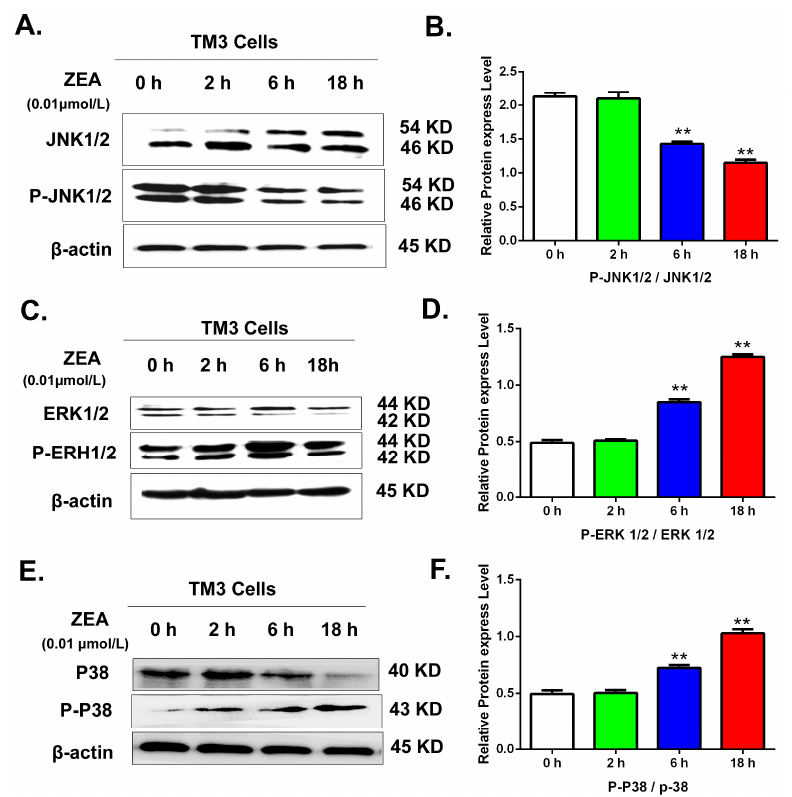
Figure 10. The e ff ects of ZEA on the MAPK family proteins including JNK1 / 2, p-JNK1 / 2, ERK1 / 2, Figure 10. The effects of ZEA on the MAPK family proteins including JNK1/2, p-JNK1/2, ERK1/2, P- P-ERK1 / 2, p38 and p-p38. After treated with 0.01 µ mol / L ZEA, cells were harvested to detect the ERK1/2, p38 and p-p38. After treated with 0.01 μ mol/L ZEA, cells were harvested to detect the rations rations of JNK1 / 2 / p-JNK1 / 2, ERK1 / 2 / P-ERK1 / 2 and p38 / p-p38. ( A ) The e ff ects of ZEA on the expressions of JNK1/2/p-JNK1/2, ERK1/2/P-ERK1/2 and p38/p-p38. ( A ) The effects of ZEA on the expressions of of the JNK1 / 2 and p-JNK1 / 2. ( B ) The rations of JNK1 / 2 / p-JNK1 / 2. ( C ) The e ff ects of ZEA on the the JNK1/2 and p-JNK1/2. ( B ) The rations of JNK1/2/p-JNK1/2. ( C ) The effects of ZEA on the expressions of the ERK1 / 2 and P-ERK1 / 2. ( D ) The rations ofERK1 / 2 / P-ERK1 / 2. ( E ) The e ff ects of ZEA expressions of the ERK1/2 and P-ERK1/2. ( D ) The rations ofERK1/2/P-ERK1/2. ( E ) The effects of ZEA on the expressions of the p38 and p-p38. ( F ) The rations of p38 / p-p38.Values represent the mean ± SD. on the expressions of the p38 and p-p38. ( F ) The rations of p38/p-p38.Values represent the mean ± SD. * p < 0.05, ** p < 0.01 compared to the 0 h * p < 0.05, ** p < 0.01 compared to the 0 h group.